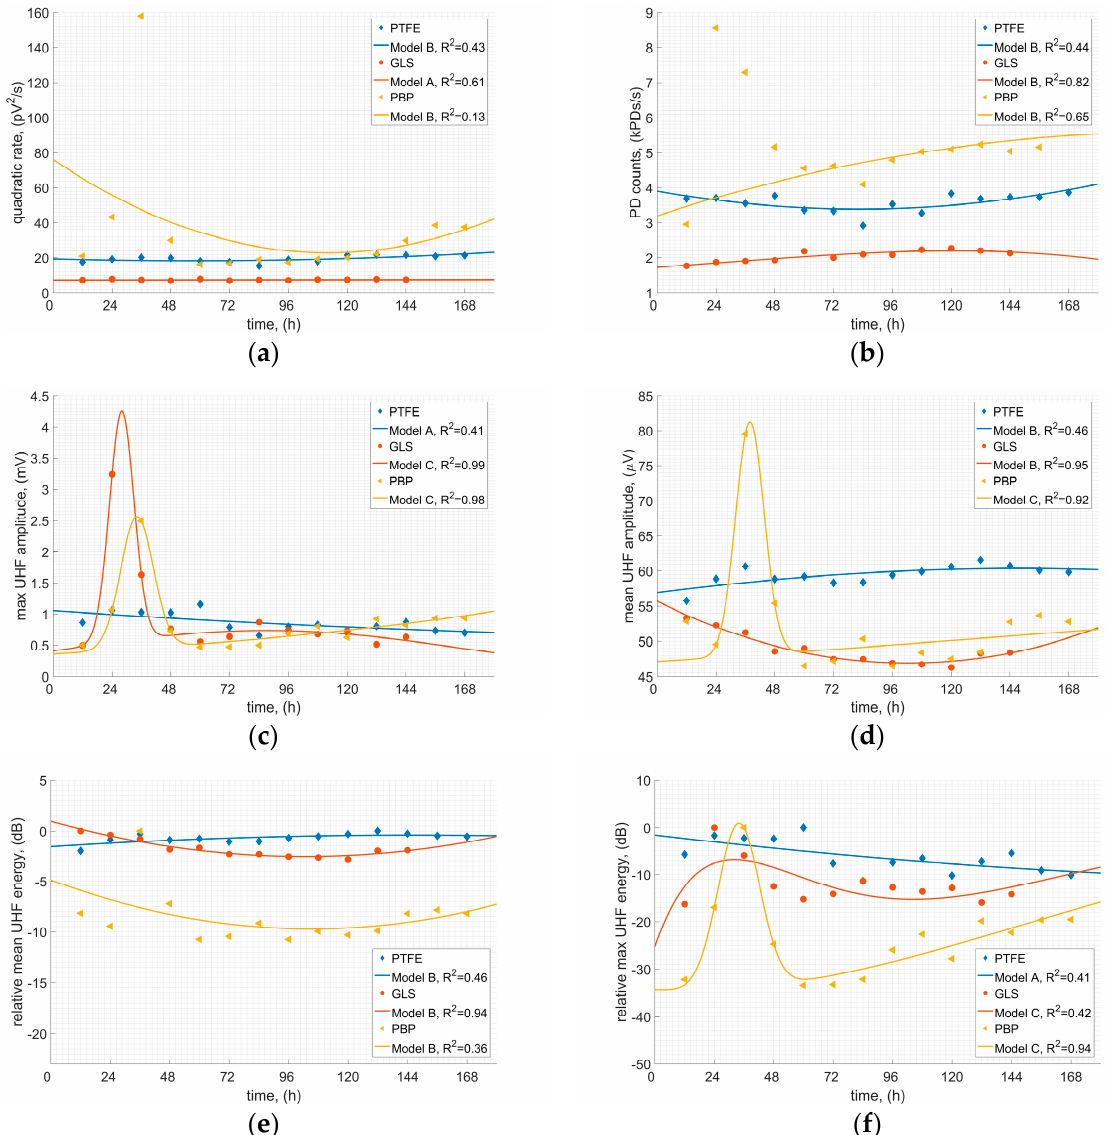
Figure 6. Variability of the selected descriptors of the UHF signals emitted by SD within 168 h: ( a ) quadratic rate; ( b ) PD counts; ( c ) max UHF amplitude; ( d ) mean UHF amplitude; ( e ) relative mean UHF energy; ( f ) relative max UHF energy.